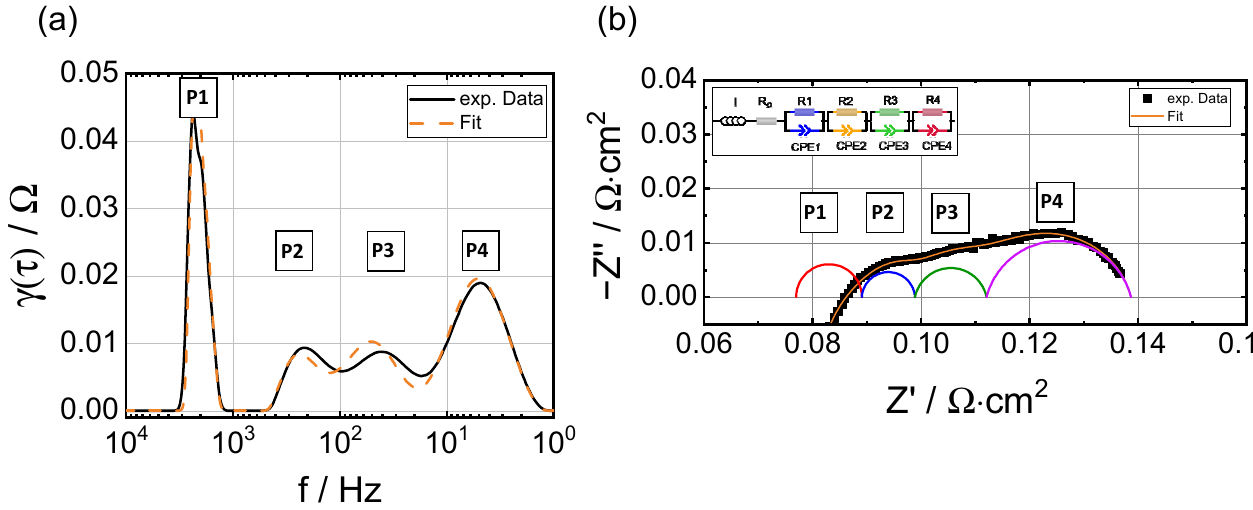
Figure 5. ( a ) Comparison of DRT plots of measured and fitted data, and ( b ) Nyquist plot fitted with 4RQ model, for steam electrolysis with 50% H 2 O + 50% H 2 gas mixture measured at 800 °C at OCV.